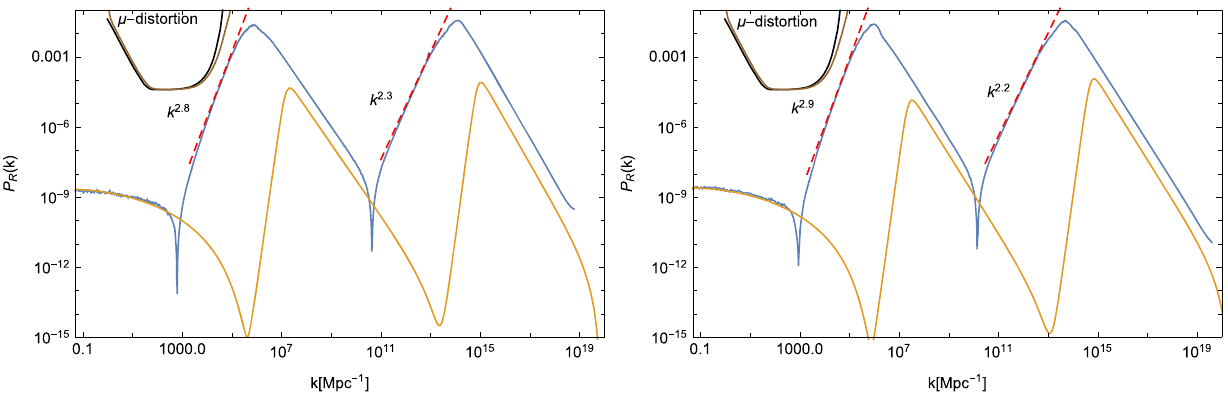
for a delta function power spectrum (black line) and for the steepest growth k 4 power spectrum (brown line) [92]